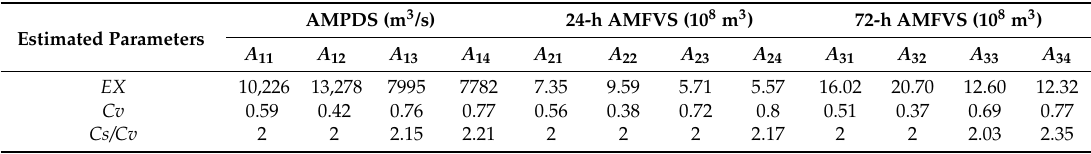
Figure 6. Fitting results for each flood characteristic series under four conditions. ( a ) Fitting results of the annual maximum peak discharge; ( b ) Fitting results of the annual maximum 24-h flood volume; and ( c ) Fitting results of the annual maximum 72-h flood volume. Table 8. Results of the estimated parameters for all flood series.